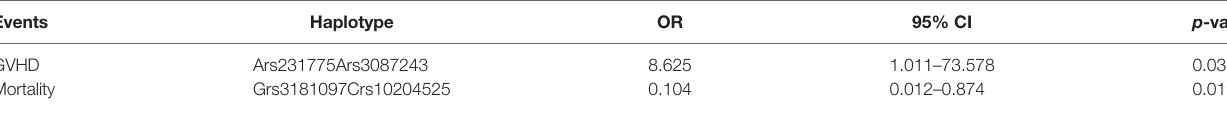
TABLE 10 | The signi fi cant haplotypes associated with